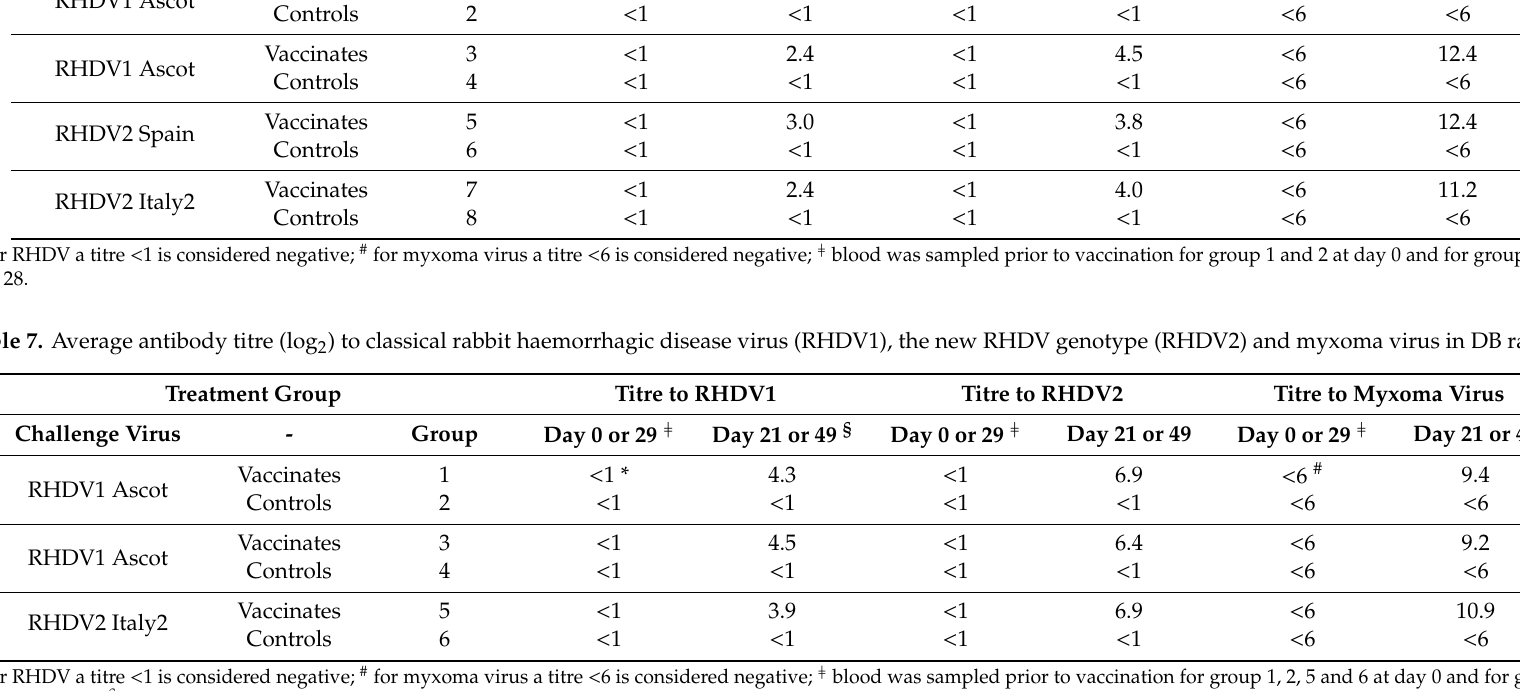
Table 6. Average antibody titre (log 2 ) to classical rabbit haemorrhagic disease virus (RHDV1), the new RHDV genotype (RHDV2) and myxoma virus in NZW rabbits. Treatment Group Titre to RHDV1 Titre to RHDV2 Titre to Myxoma Virus Challenge Virus - Group Day 0 or 28 } Vaccinates RHDV1 Ascot